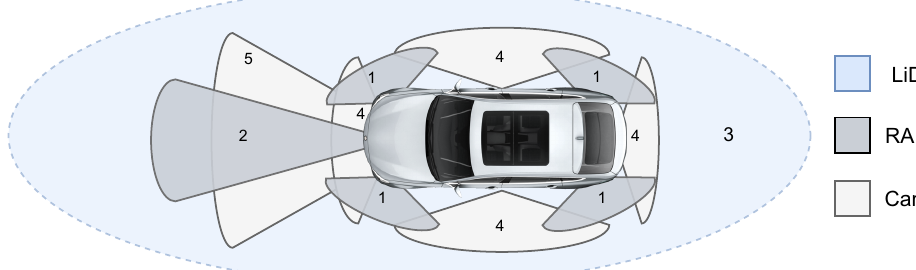
Figure 1. Perception system of a